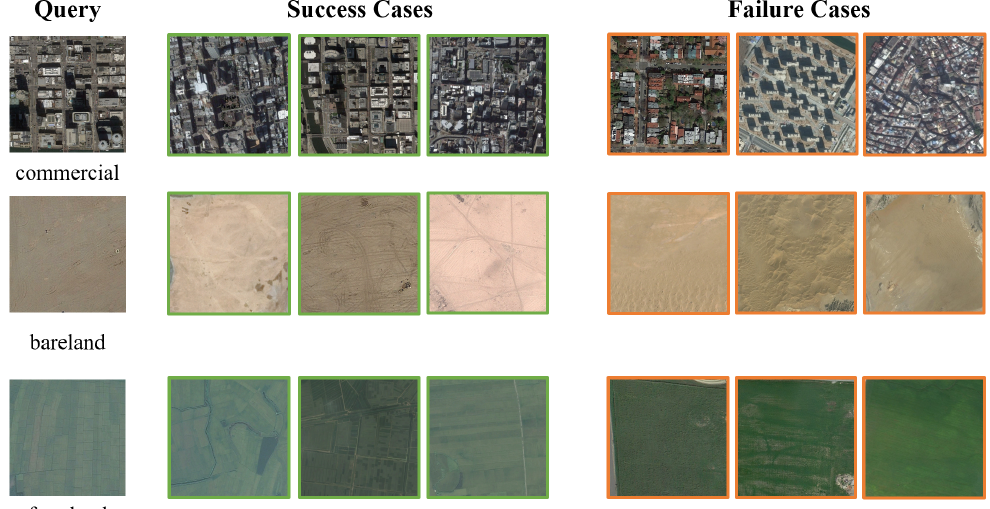
Figure 16. Examples of AID retrieval results. Column 1 is the query sample, columns 2–4 are the success cases of our method, and columns 5–7 are the failure